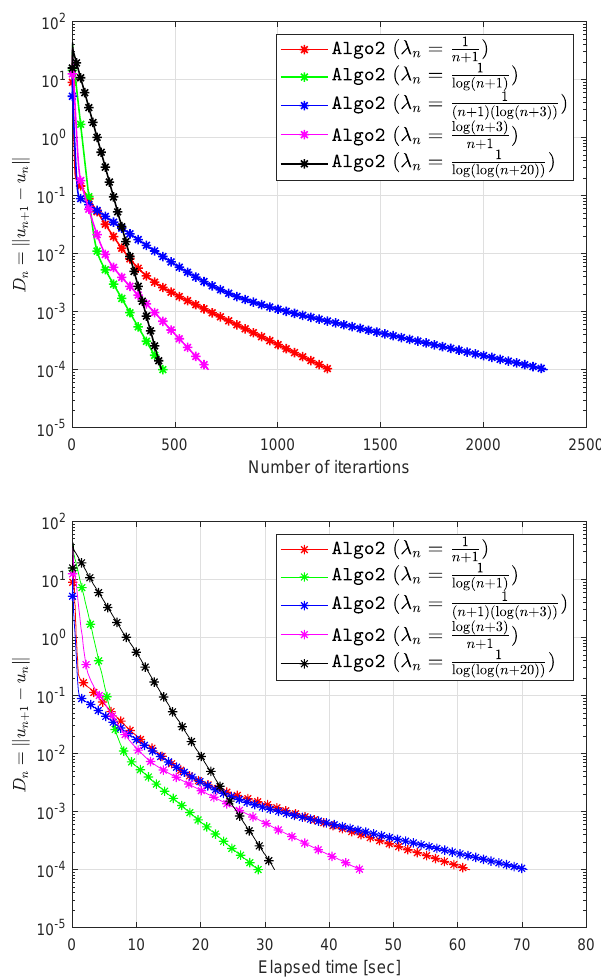
Figure 3. Algorithm 2 behaviour with respect to different step-size sequences λ n